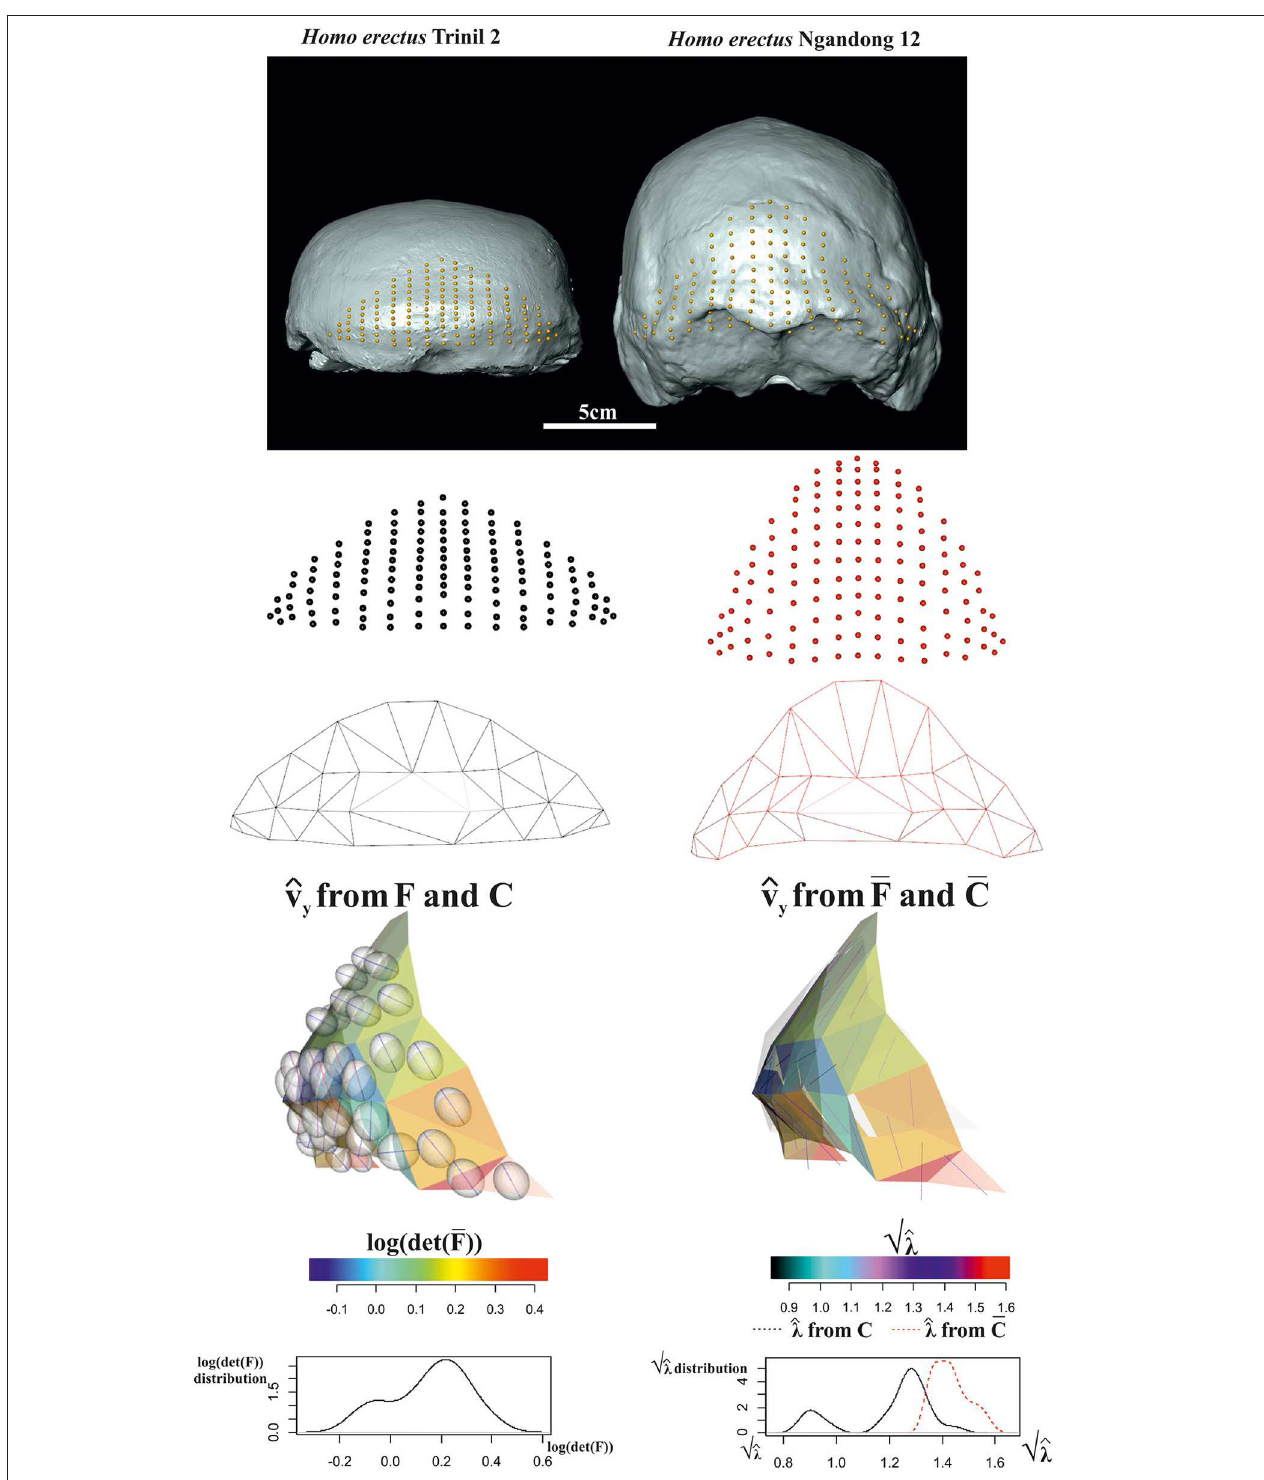
FIGURE 14 | Local deformations observable between Homo erectus Trinil 2 (as source) and H. erectus Ngandong 12 (as target). 3D meshes are also shown. calculated upon F or F are shown and colored according to the corresponding metrics are also illustrated. Source and target shapes were aligned via OPA. Trinil 2 is housed at the Nationaal Museum van Natuurlijke Historie, Leiden,